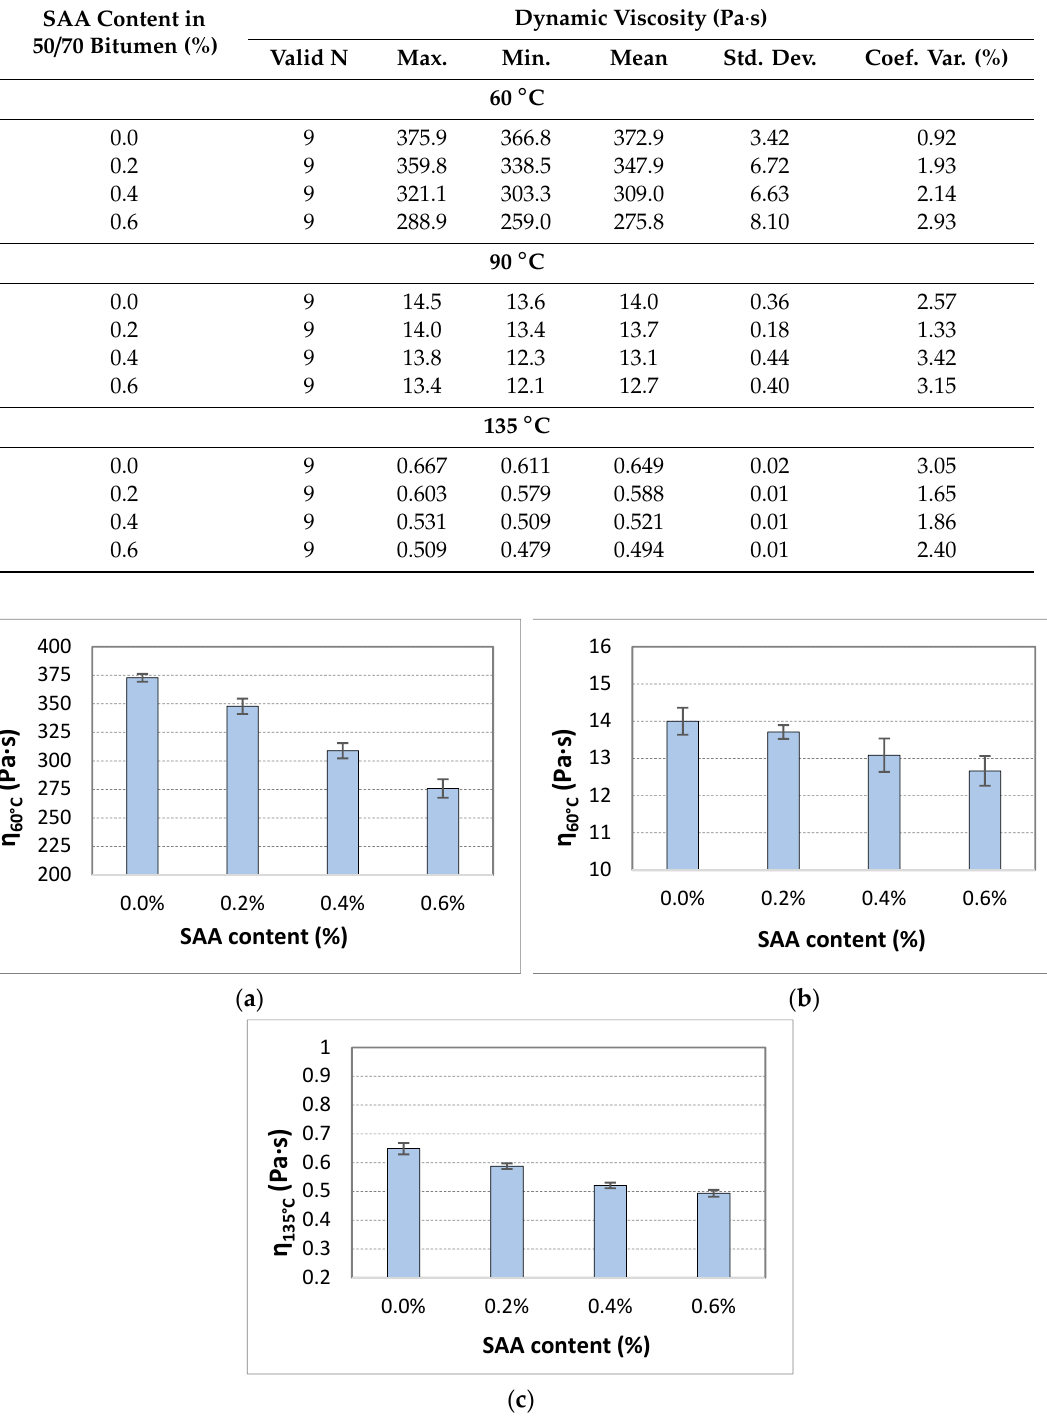
Table 6. Mean values of 50 / 70 bitumen dynamic viscosity versus SAA content and test temperature (60 ◦ C, 90 ◦ C, and 135 ◦ C).